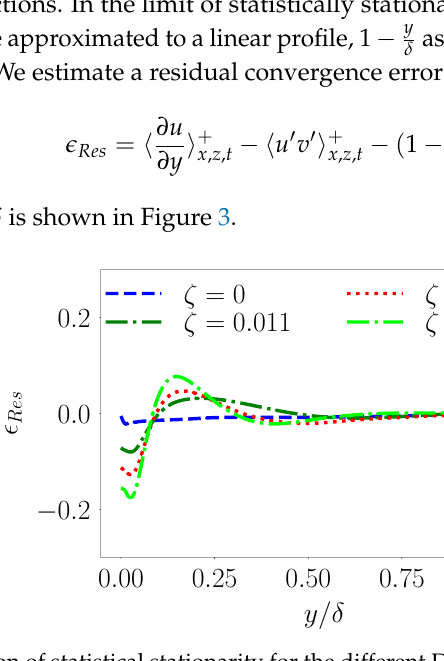
Figure 3. Quantification of statistical stationarity for the different DNS datasets using the residual of mean horizontal stress from 2500 samples collected over ~12 δ